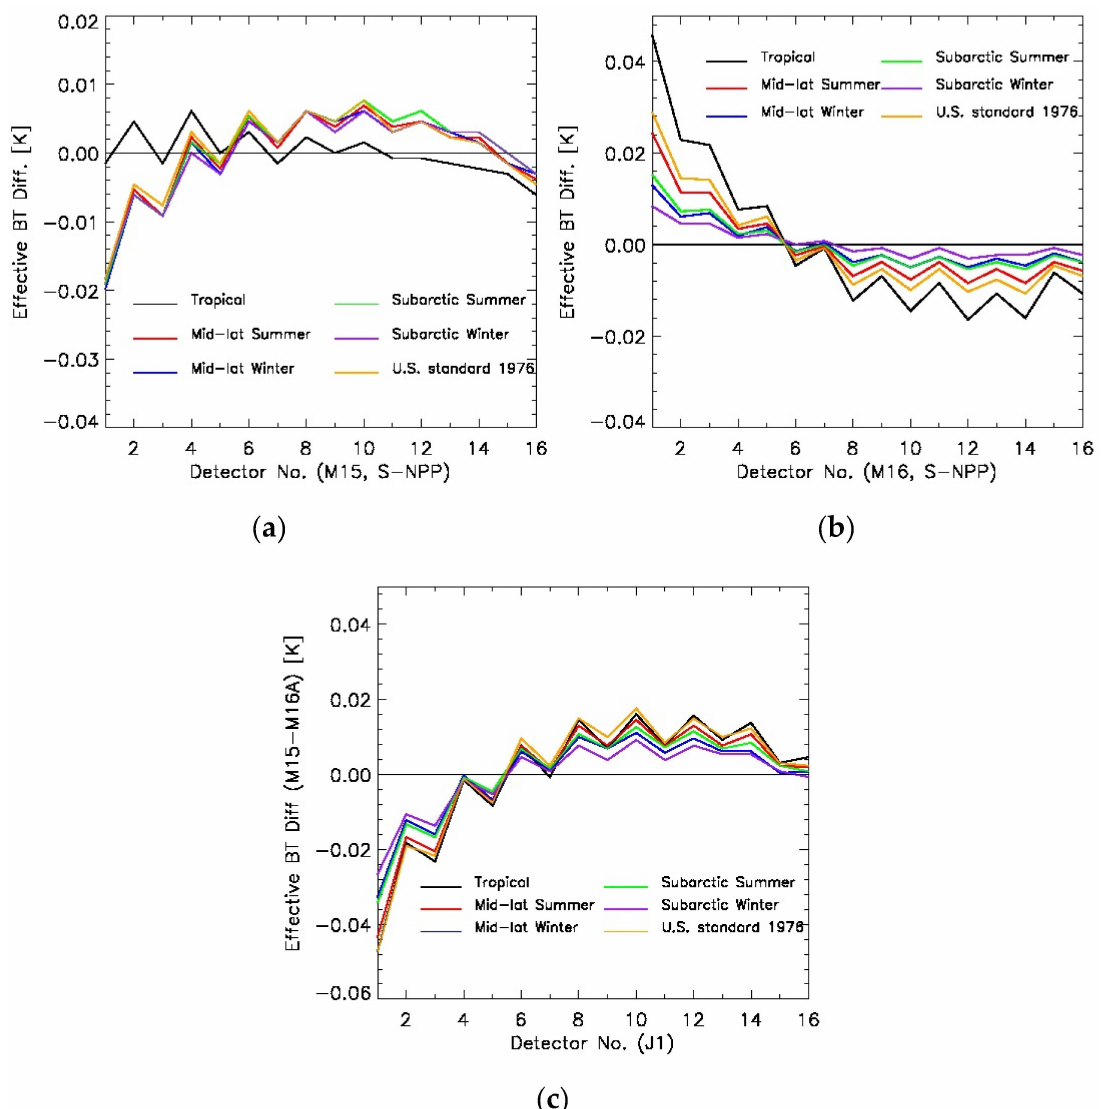
Figure 2. Effective temperature difference between detector level and band averaged RSR for six line-by-line radiative transfer model (LBLRTM) atmospheres in M15 ( a ); M16 ( b , the average of M16A and M16B); and M15 ´ M16 ( c